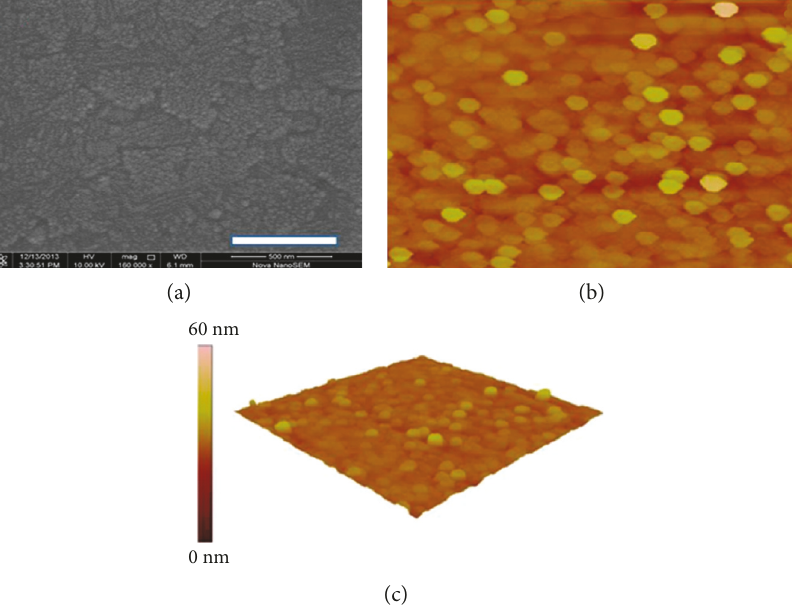
Figure 2: (a) SEM NiO fi lm prepared by spin coating, (b) and (c) AFM of NiO fi lm prepared by spin coating. Reprinted with permission from [21].